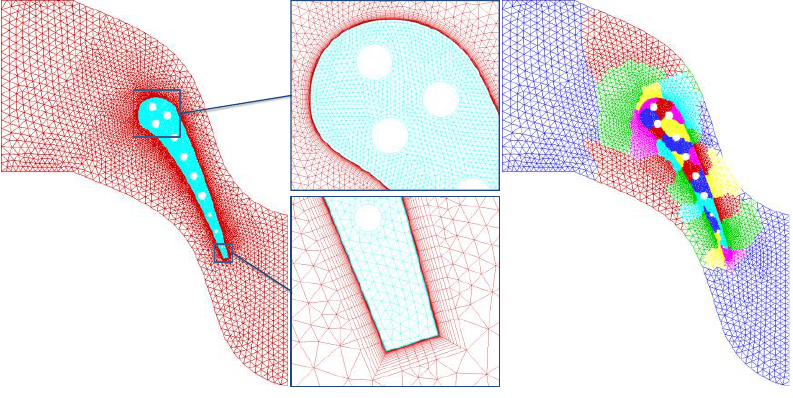
Figure 8. Mesh partition and succedent domain decomposition (into 32 subdomains) processes for the case of the turbine vane Mark